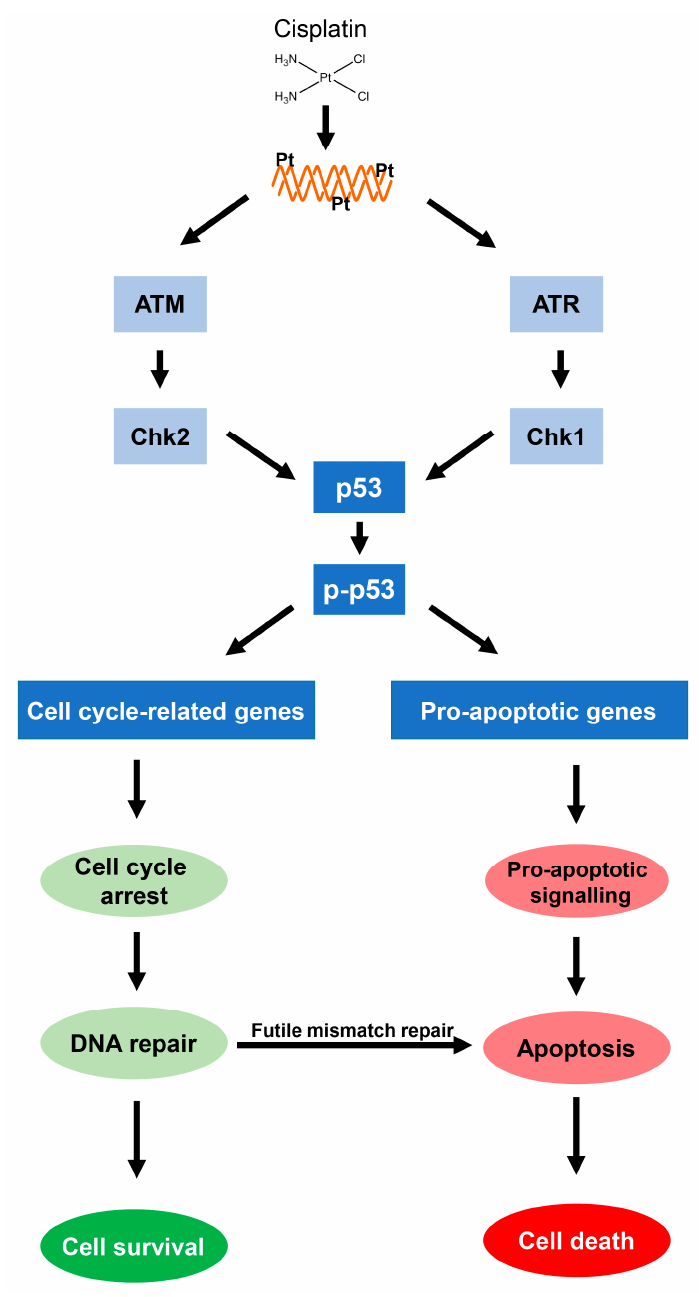
Figure 4. The p53-mediated DNA damage response. Cisplatin-induced DNA damage activates ATM/Chk2 and/or ATR/Chk1, which leads to phosphorylation of p53. Activated p53 induces expression of genes related to the cell cycle control allowing time for DNA repair. If the amount of damage exceeds the cellular repair capacity, apoptosis-related genes will be expressed leading to apoptotic cell death. Futile mismatch repair (MMR) also contributes to cisplatin-induced apoptosis. As stated, p53 is a key player in the cellular response to cisplatin and controls the down-stream events cell cycle arrest/repair or apoptosis, largely through transcriptional activation of numerous p53 response genes [92]. It has been observed that low levels of cisplatin DNA damage transiently activate p53 favoring cell cycle arrest, while high levels